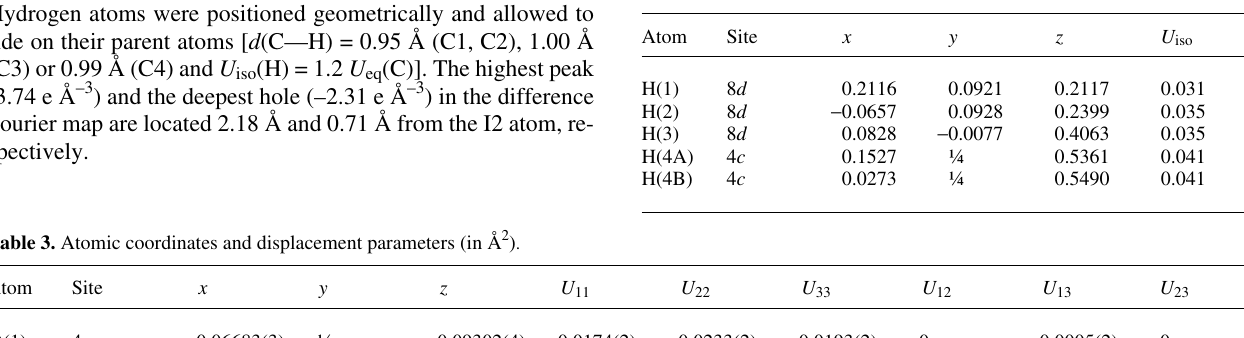
Table 2. Atomic coordinates and displacement parameters (in Å 2 ) .